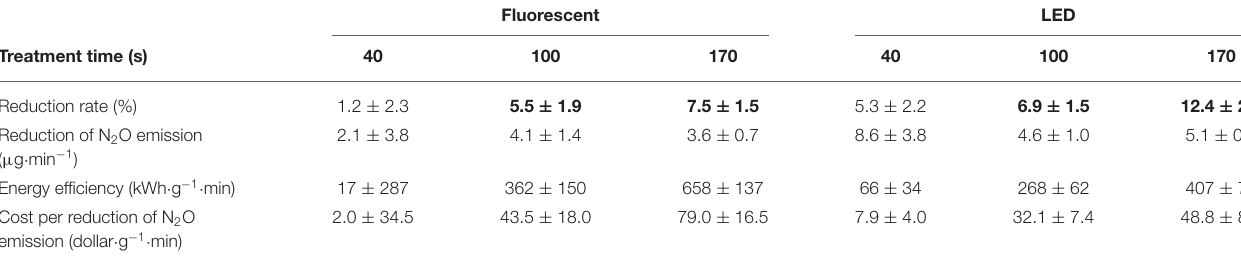
TABLE 10 | Economic analysis of N 2